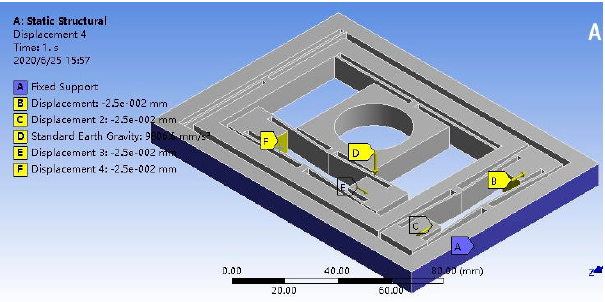
Figure 10. Boundary conditions for simulation of micro-positioning platform.